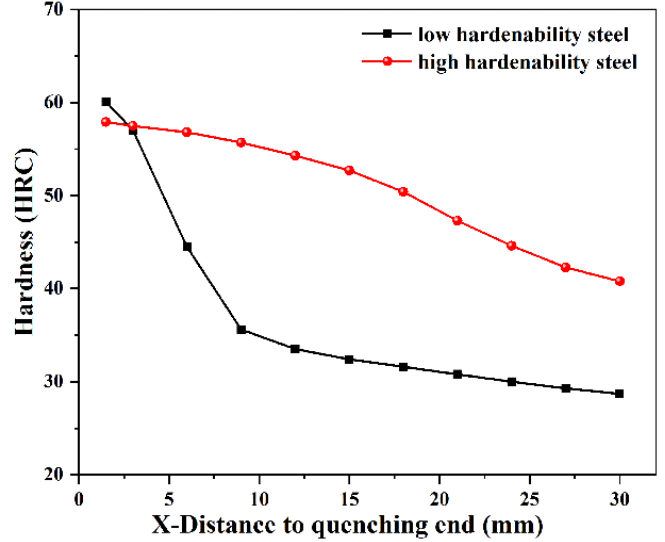
Figure 1. Hardenability curves for low- and high-hardenability steels.